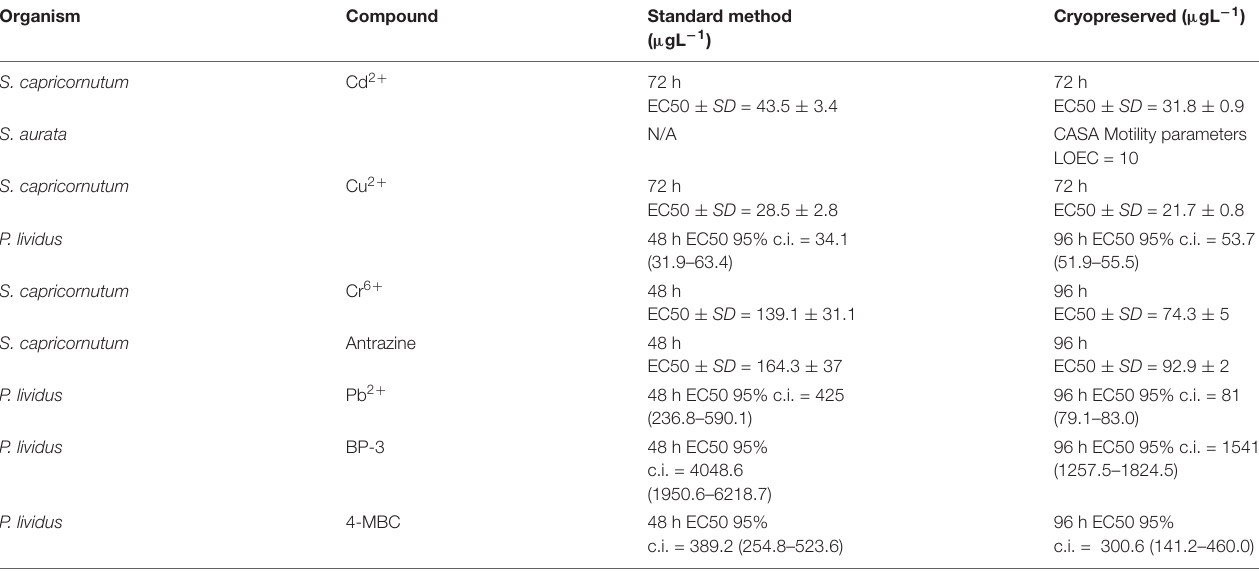
TABLE 2 | Available toxicological information for different contaminants using cryopreserved cells.